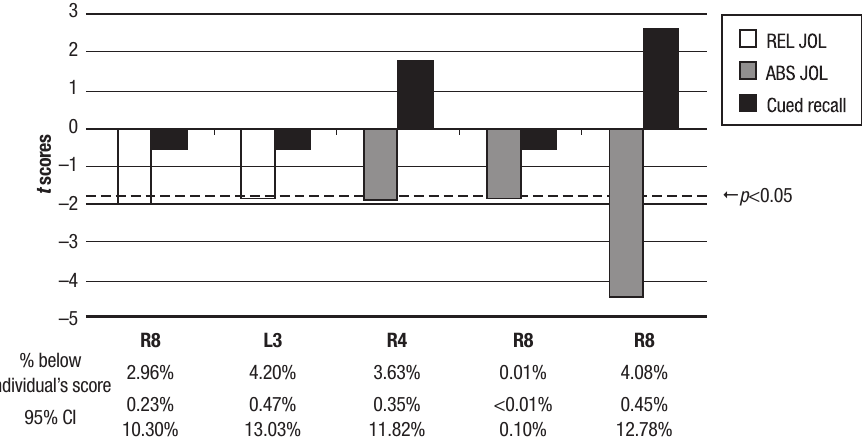
Figure 1. Cases depicting dissociation between memory monitoring and memory capacity. Measures are from the Metamemory Experimental Task. Scores under the dotted line indicate deficit (p<0.05). ! p Percentage of healthy population, estimated from the control group falling below individual’s deviant score and the 95% confidence interval (CI) is displayed at the bottom.